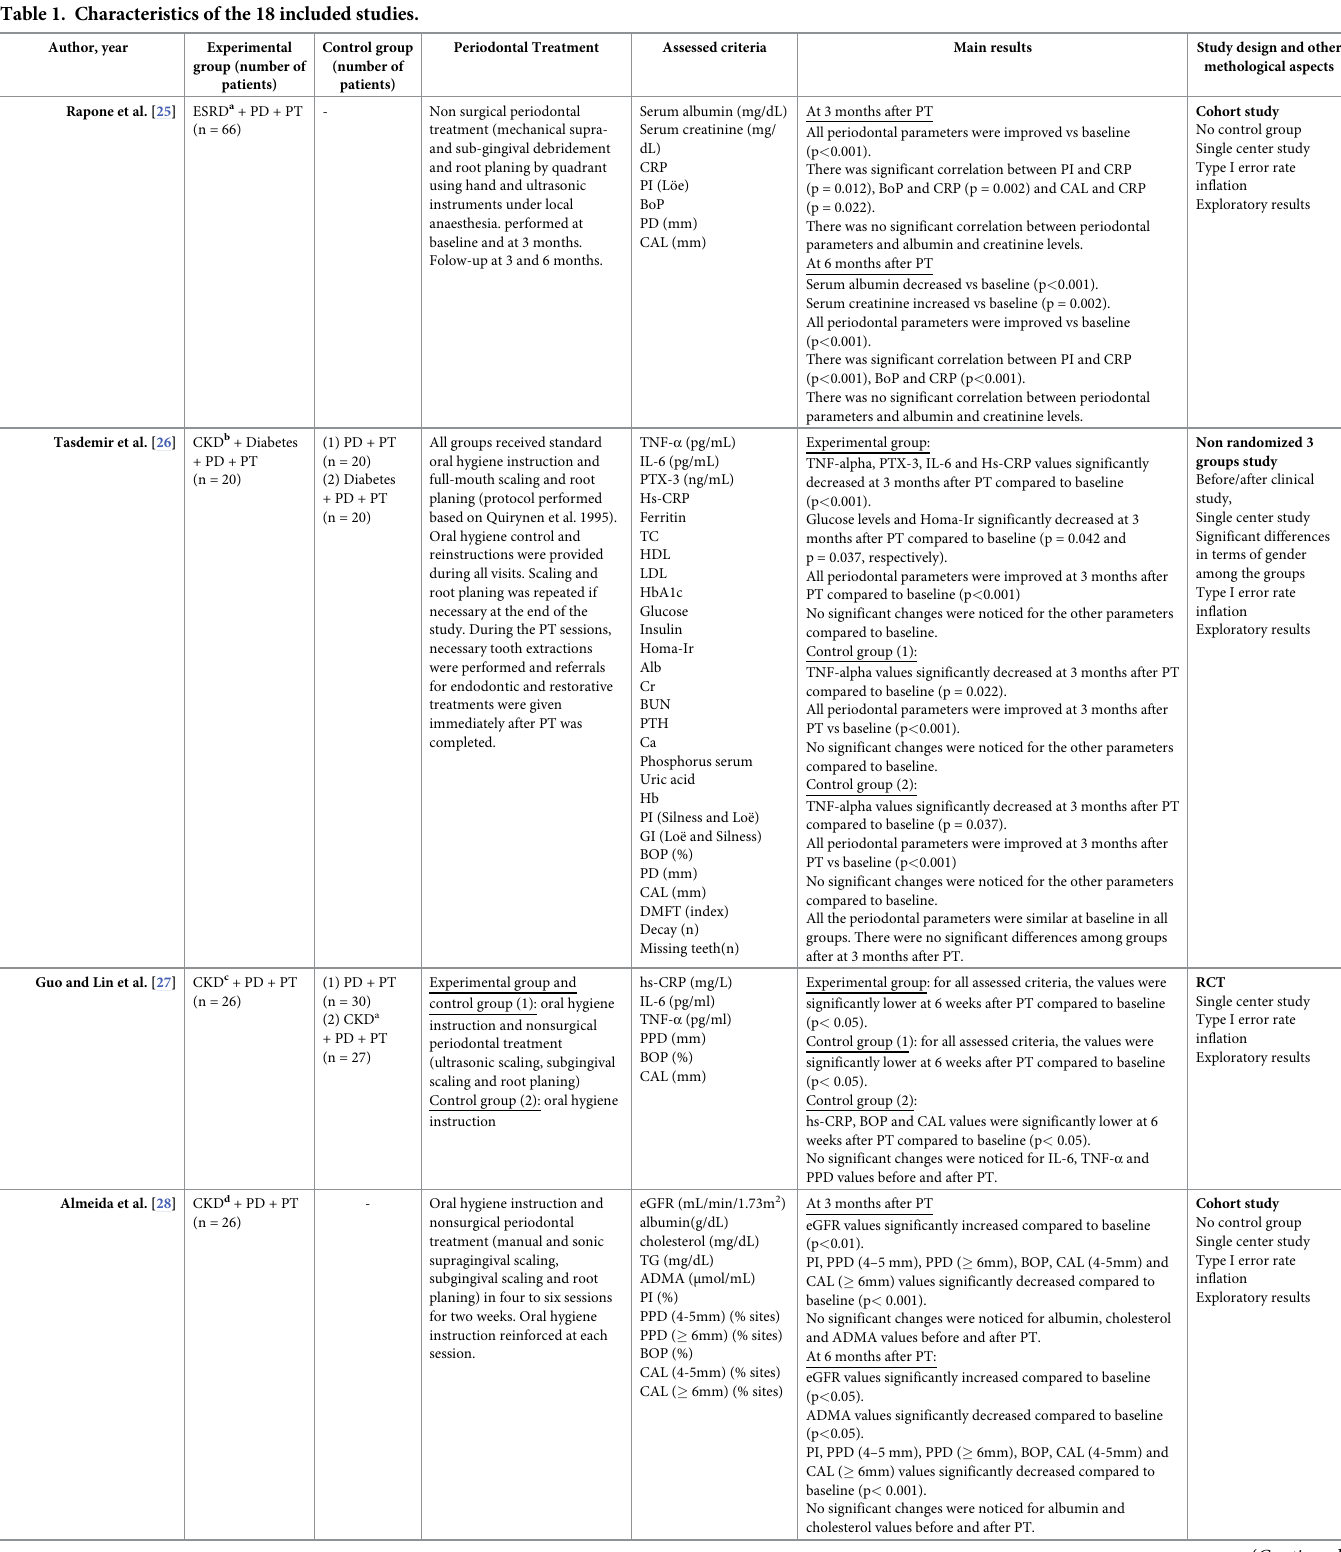
Table 1. Characteristics of the 18 included